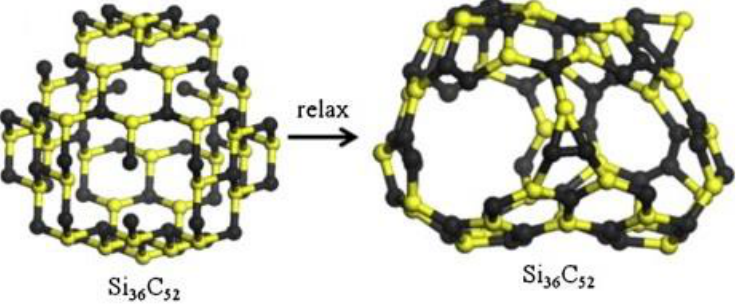
Figure 11. The formation process of a SiC nanocage in MD simulation, modified picture of [81].